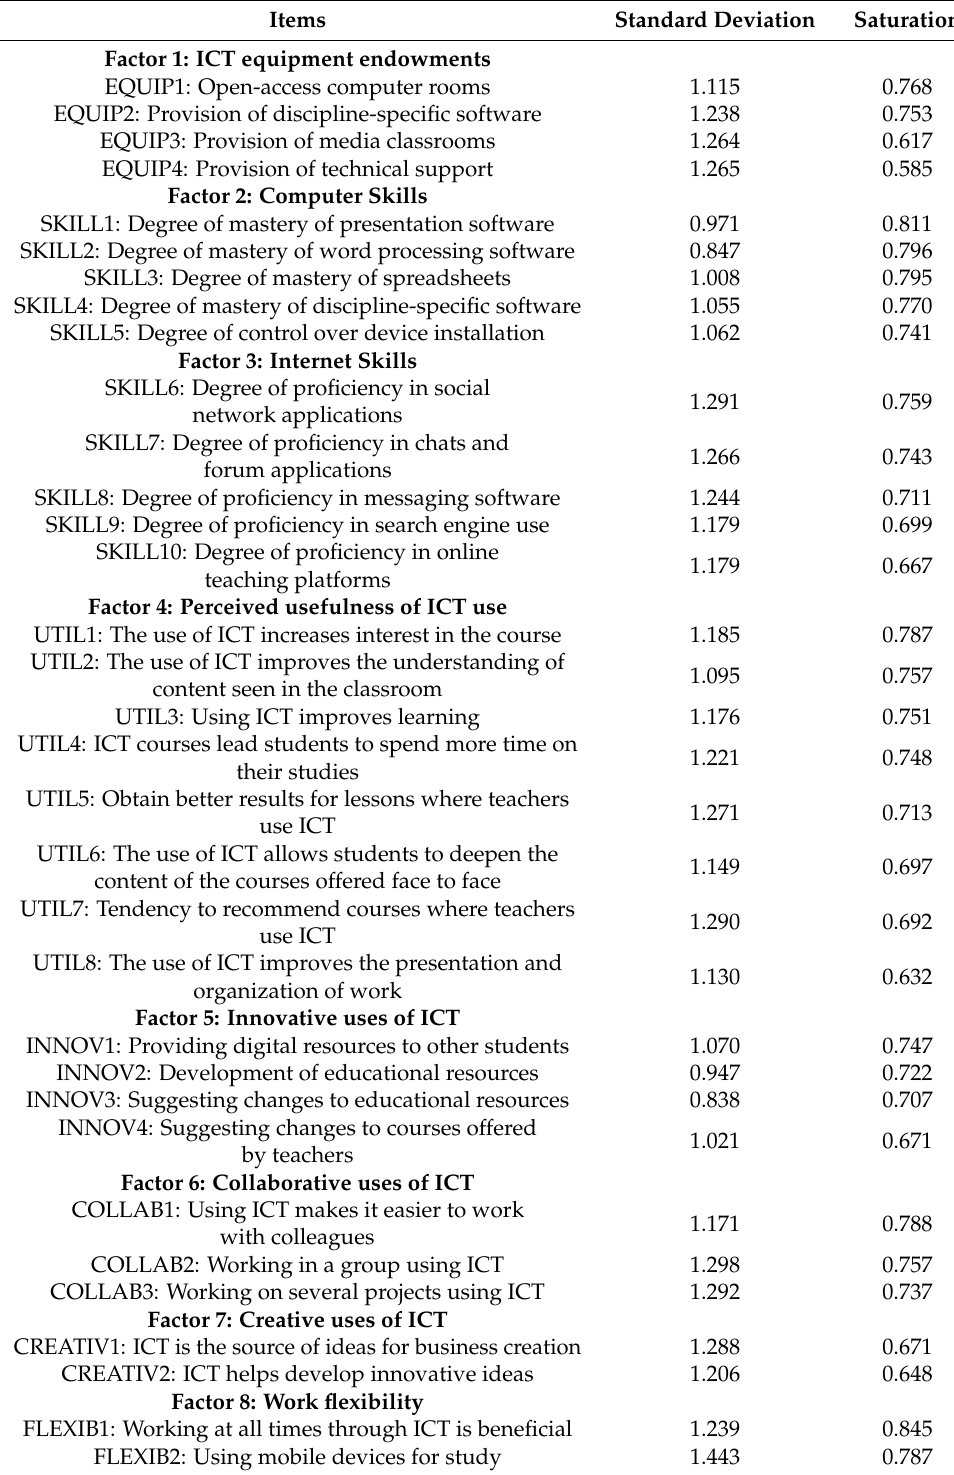
Table 3. Rotary factorial matrix of the explanatory variables for the level of ICT skills and uses by